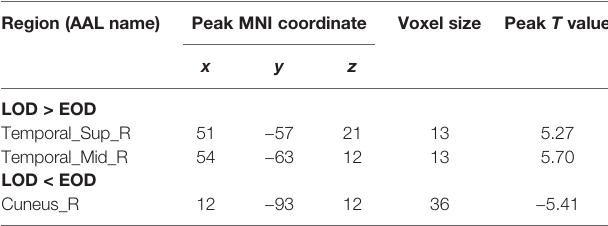
TABLE 3 | Brain areas showing different DC between LOD and EOD patients ( p < 0.05,